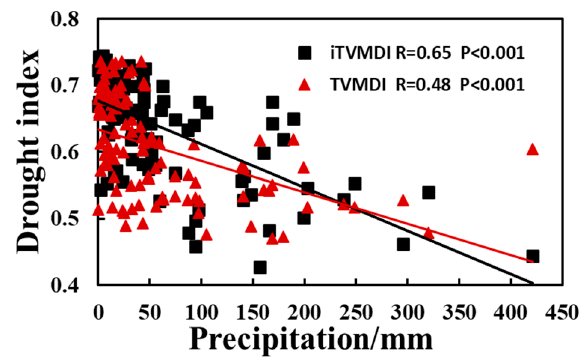
Figure 4. Scatterplots between precipitation and drought indices of nine meteorological stations in 2016.